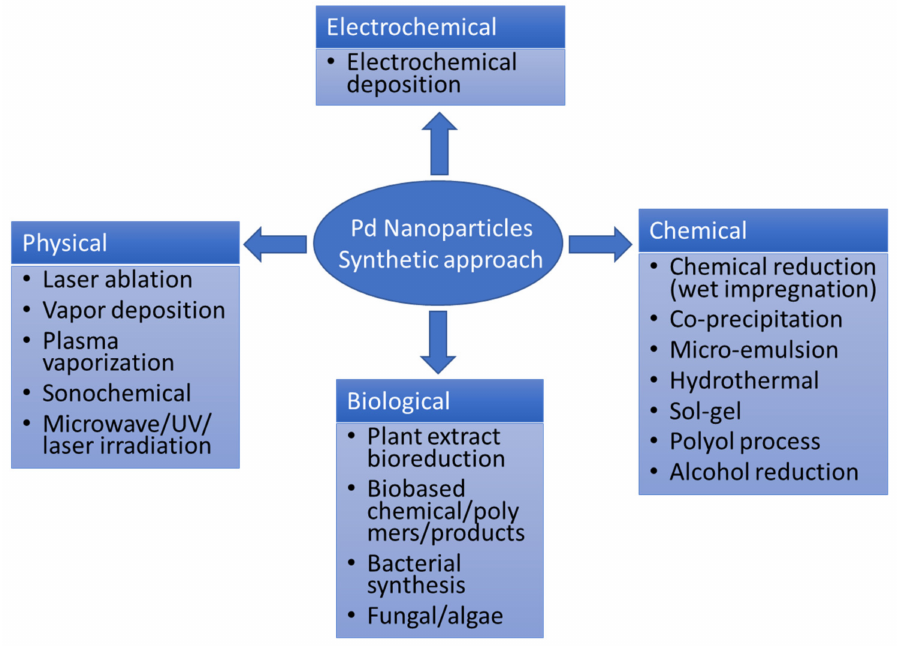
Figure 1. Physical, chemical and biological synthetic approach to Pd nanoparticles